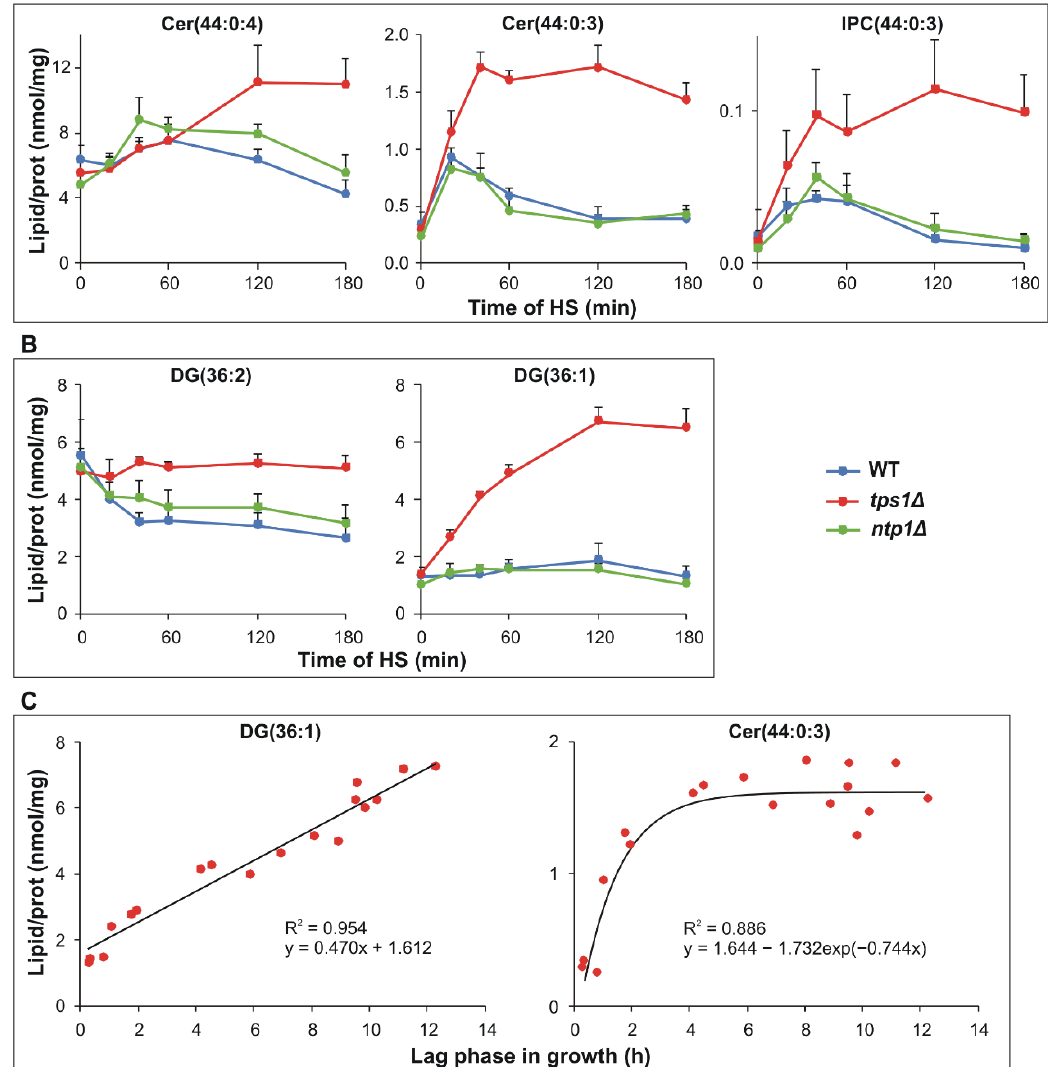
Figure 5. Signaling lipid production in response to heat stress (HS). Yeast cells were heat-stressed at 40 °C for 0–180 min. ( A ) Kinetics of sphingolipid species Cer(44:0:4, t20:0/24:0-OH), Cer(44:0:3, t20:0/24:0) and IPC(44:0:3, t20:0/24:0). ( B ) Kinet- ics of major diglyceride species DG(36:2) and DG(36:1). ( C ) Relationship between the lag period and signaling lipid levels in tps1 Δ cells. Black solid lines represent the fitted curves and R 2 values represent the goodness of fit. Data in panel ( A ) and ( B ) are presented as mean ± SD, n = 3 (independent experiments); for significance values, see Table S4. In panel ( C ), individual data are displayed. WT, wild-type; tps1 Δ , trehalose-deficient; ntp1 Δ , trehalase-deficient S. pombe strains; Cer, ceramide, IPC, inositolphosphoceramide; DG, diglyceride.